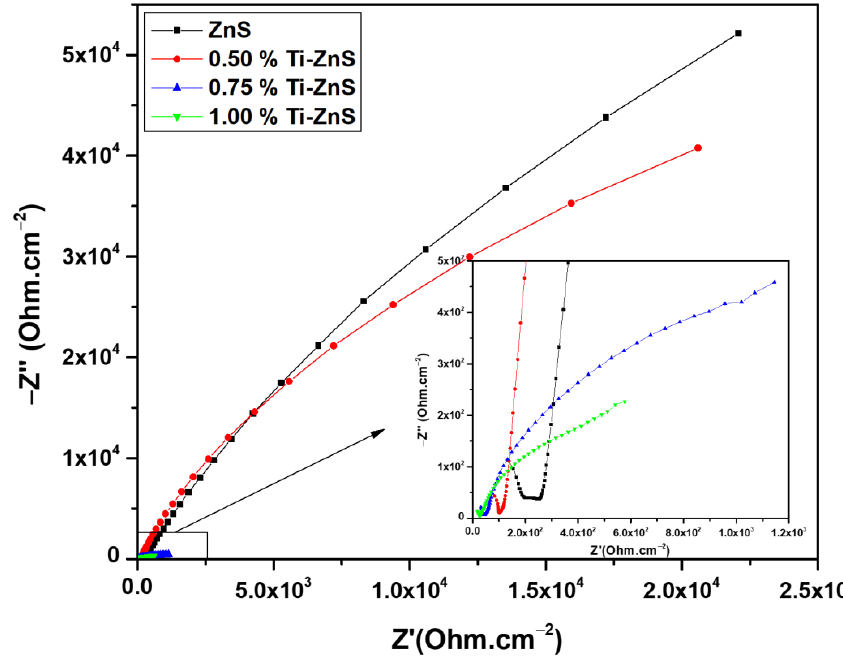
Figure 8. Nyquist plots of undoped ZnS and Ti doped ZnS thin films under